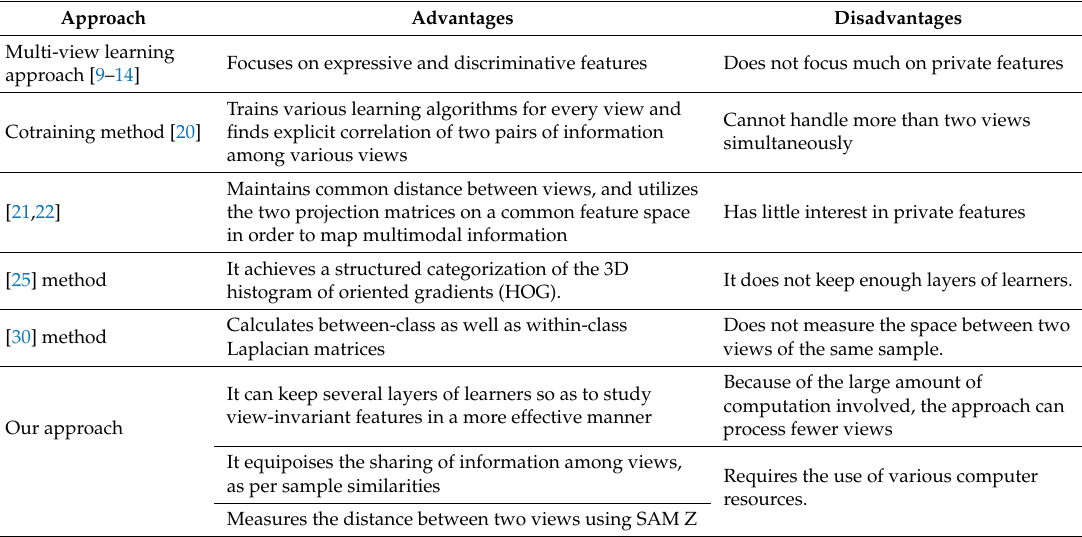
Table 1. Advantages and disadvantages of used